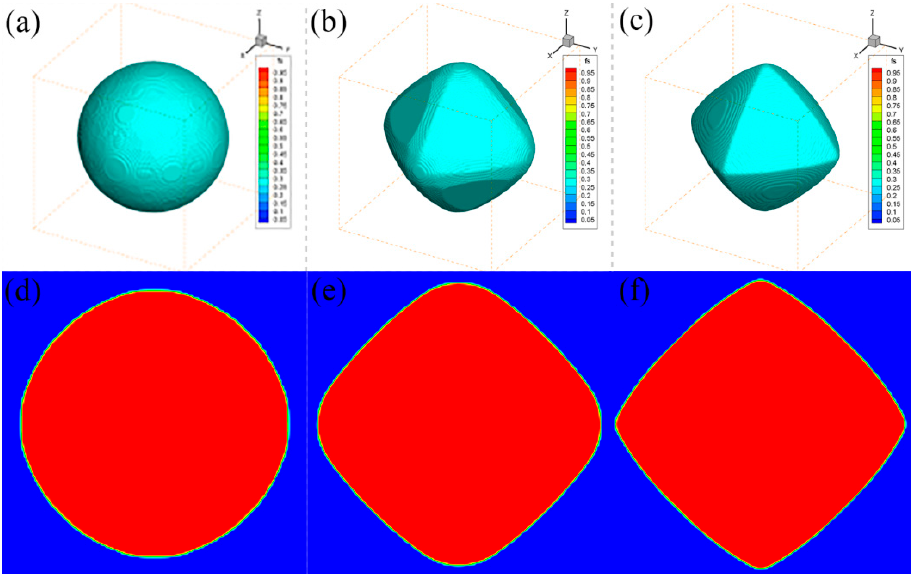
Figure 2. Numerical simulation results of different interface energy anisotropy, α = 1.5; ( a ) k = 2; ( b ) k = 5.5; ( c ) k = 9.5; ( d )–( f ) are the corresponding cross sections of solid fraction.